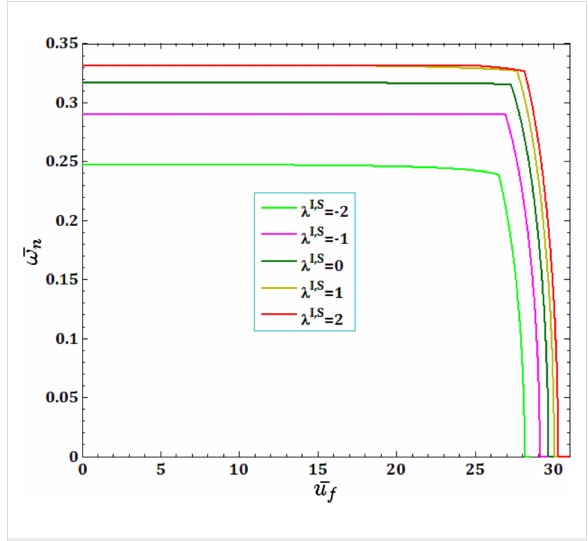
ness, DNF and critical fluid velocity increase and pull-in voltage in λ I,S = 0 and λ I,S = − 2 has a maximum and a minimum value.